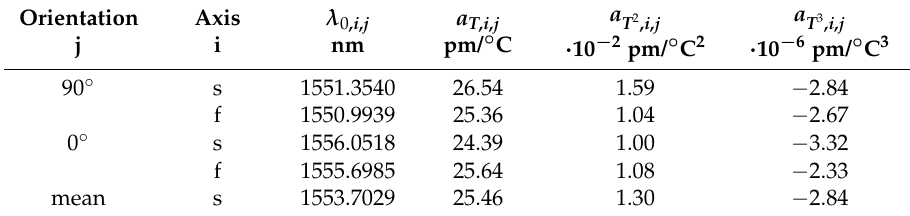
Figure 9. Residuals of the temperature calibration: FBG in the 0°-orientation in green, FBG in the 90°- orientation in blue, and mean values in grey. Table 2. Fitting parameters of the temperature calibration of the PM tandem.